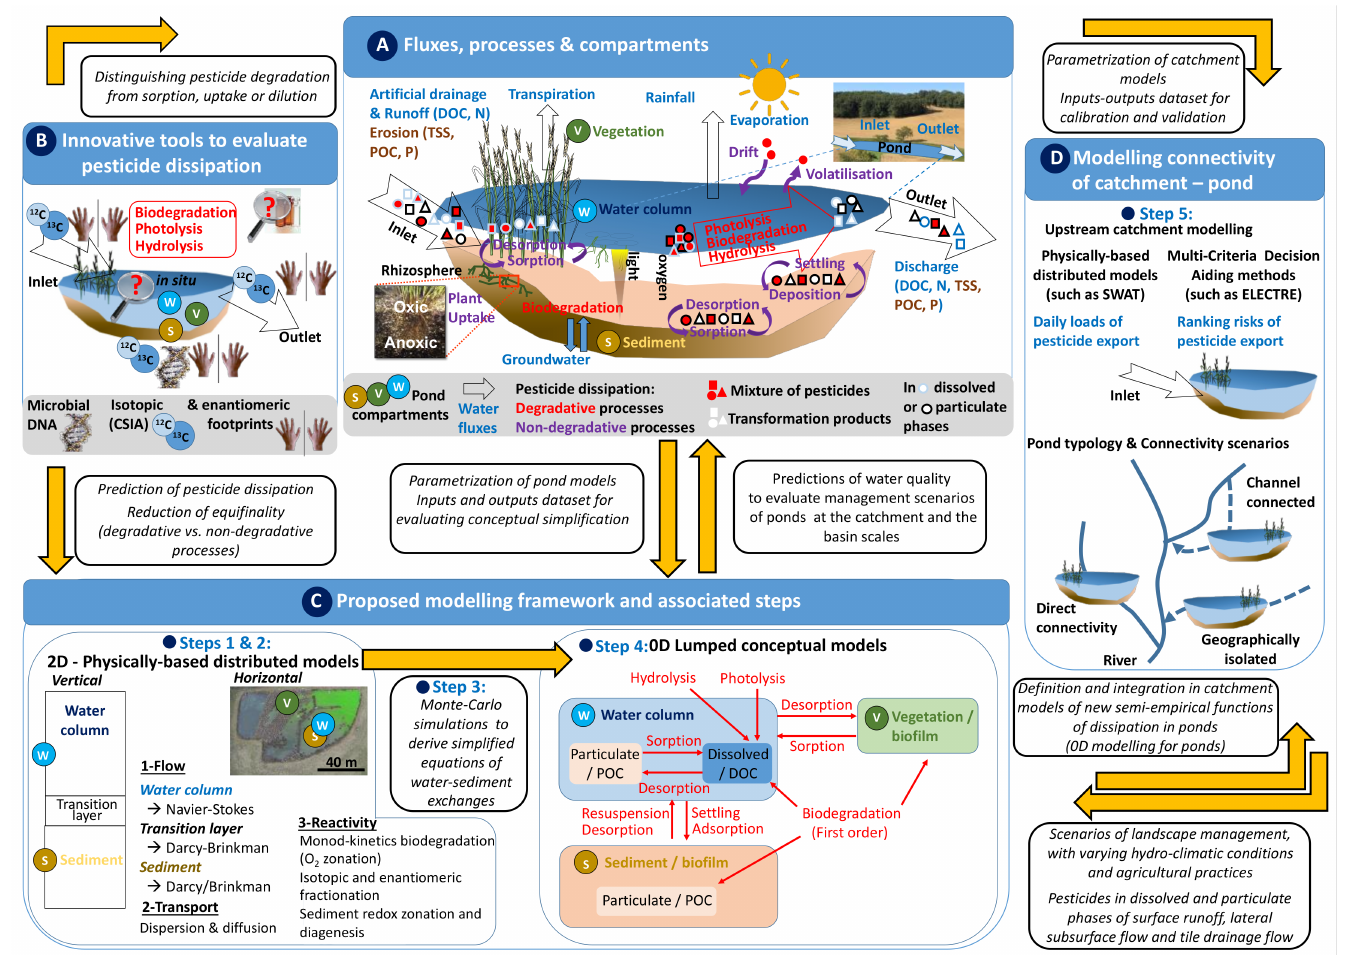
Figure 1. Evaluation and prediction of pesticide dissipation in ponds and the role of ponds at the catchment scale. ( A ) Fluxes, processes and compartments of ponds. ( B ) Innovative tools to distinguish pesticide degradative and non-degradative processes. ( C ) Pond modelling framework sketched in this review and associated steps. ( D ) Modelling the catchment–pond connectivity to integrate the cumulative effect of ponds in terms of risks of pesticides transfer and fluxes at the catchment scale and elaborate management scenarios. TSS: total suspended solids; DOC: dissolved organic carbon; N: nitrogen; P: phosphorus; POC: particulate organic